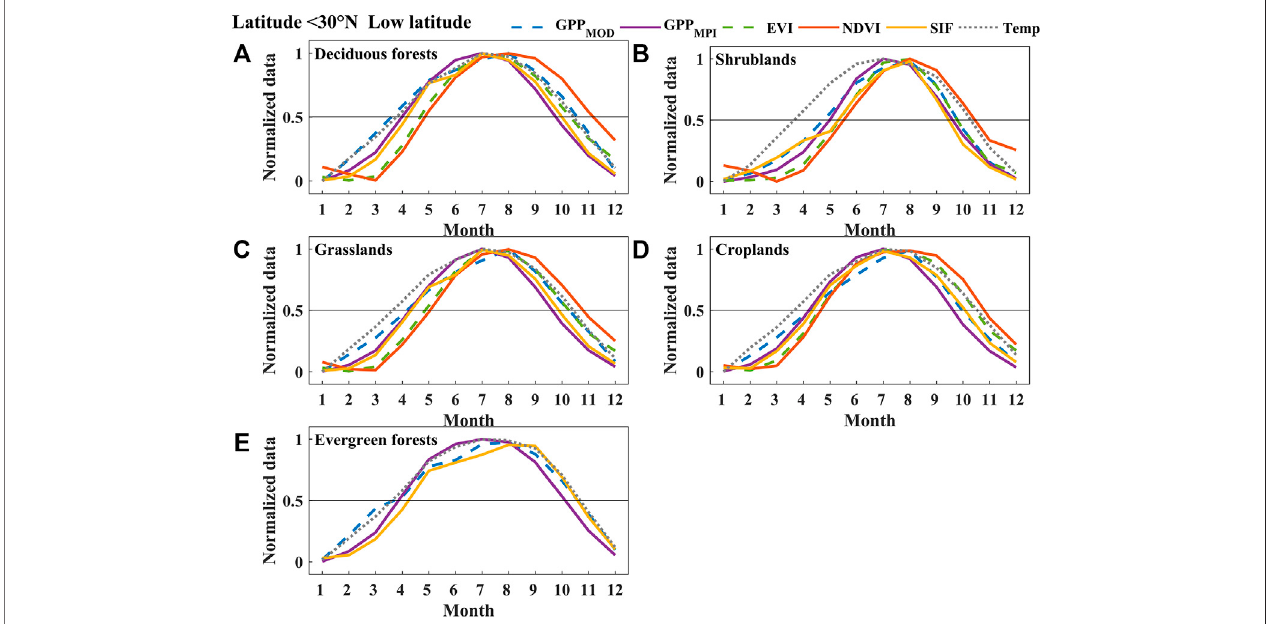
FIGURE 6 | The normalized mean seasonal cycle of area-averaged GPP MOD , GPP MPI , NDVI, EVI, SIF, and Temperature (Temp) of deciduous forests (A) , shrublands (B) , grasslands (C) , croplands (D) , and evergreen forests (E) in the low-latitude region (below 31 ° N) of China between 2007 and 2013. Error bars in all subplots represent the monthly standard deviations during 2007 –